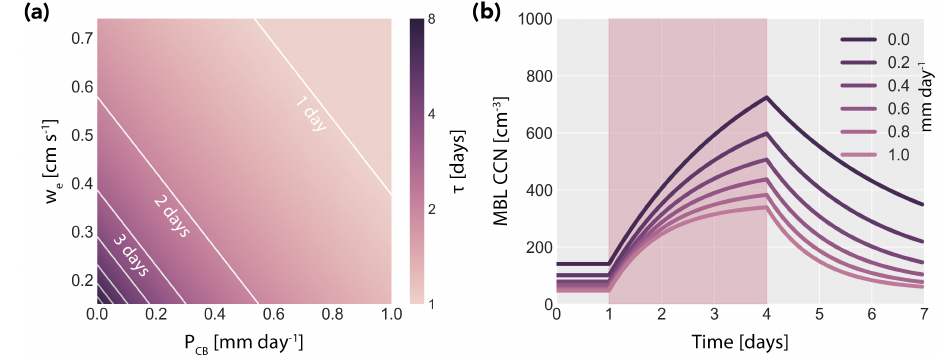
Figure 8. (a) Characteristic (e-folding) entrainment mixing timescale for a range of plausible w e and P CB values. Contours at 1-day intervals for reference. (b) Evolution of CCN MBL over time in response to the introduction of a smoke plume with CCN FT = 1000cm − 3 at day 1 and its removal at day 4 (highlighted). Curves show results for a range of equilibration timescales with z i = 1km, w e = 0 . 4cms − 1 , h = 300m, and P CB varying between 0 and 1mmday − 1